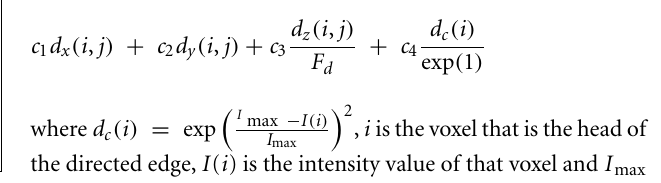
FIGURE 3 | Multi-scaling procedure. The center of the sphere is the currently analyzed seed point (green). Graph vertices connected or disconnected from the seed point are respectively blue and yellow. (A) No branching detected.